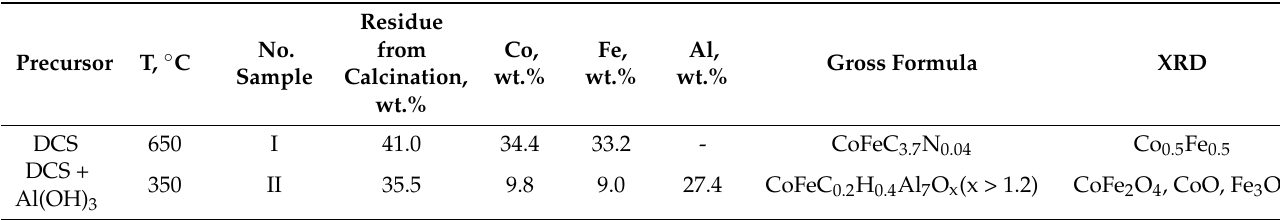
Table 1. Characterization of catalytic compositions.